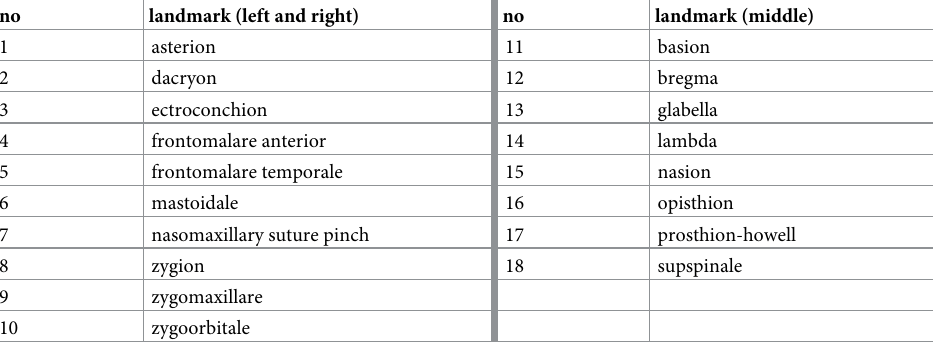
Table 1. 2 × 10 side landmarks and 8 middle